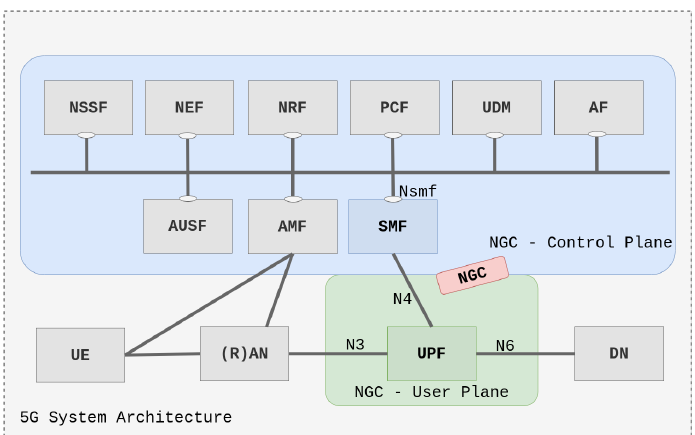
Figure 3. Simplified 5G System architecture. Highlighted, the SMF and UPF components are addressed in the next sessions. The colored region represents the core of the 5G